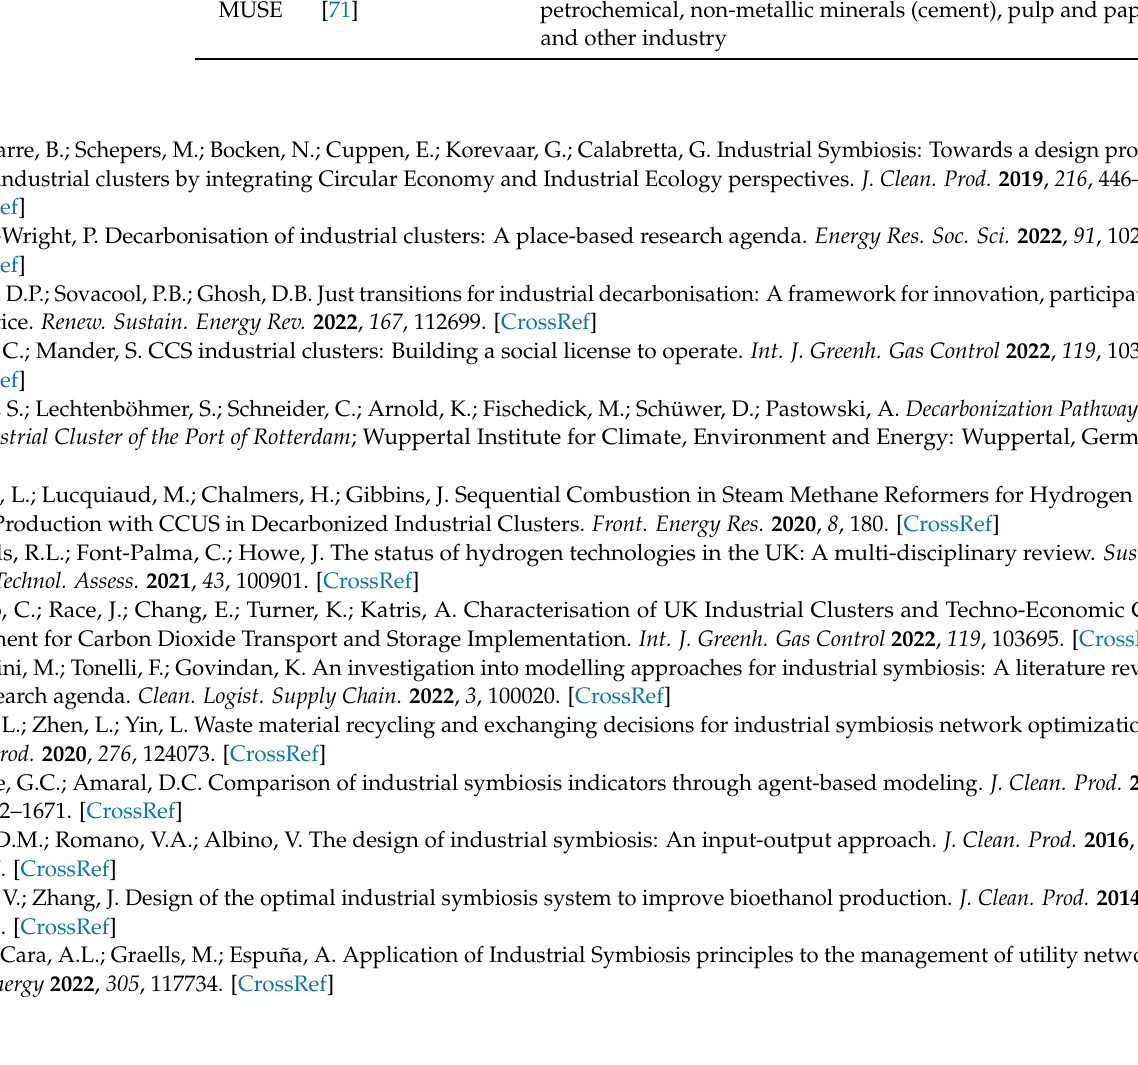
non-ferrous metals (aluminum), iron and steel, chemical and petrochemical, non-metallic minerals, pulp and paper, and other industry. [65,66] Multi-sector carbon neutrality; industry aggregated hard-to abate sectors representation included circular economy focuses on advancements in energy demand sectors; best [67,68] available technologies in industry included focuses on decarbonization options for UK